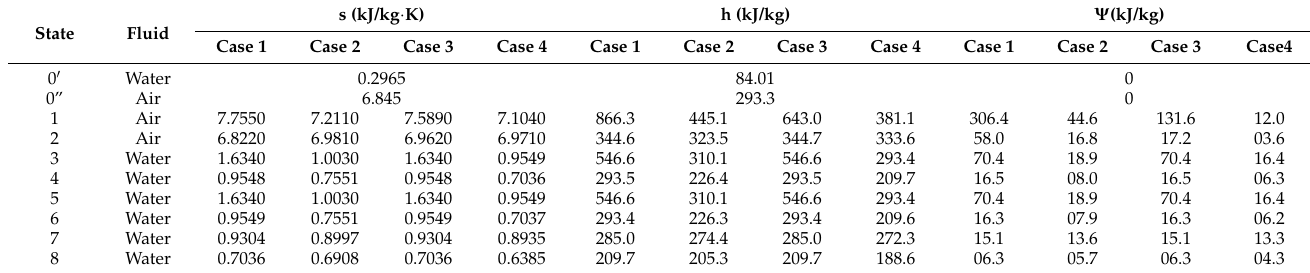
Table 2. Specific entropy, enthalpy and exergy values of the state points given in Figure 1 based on created